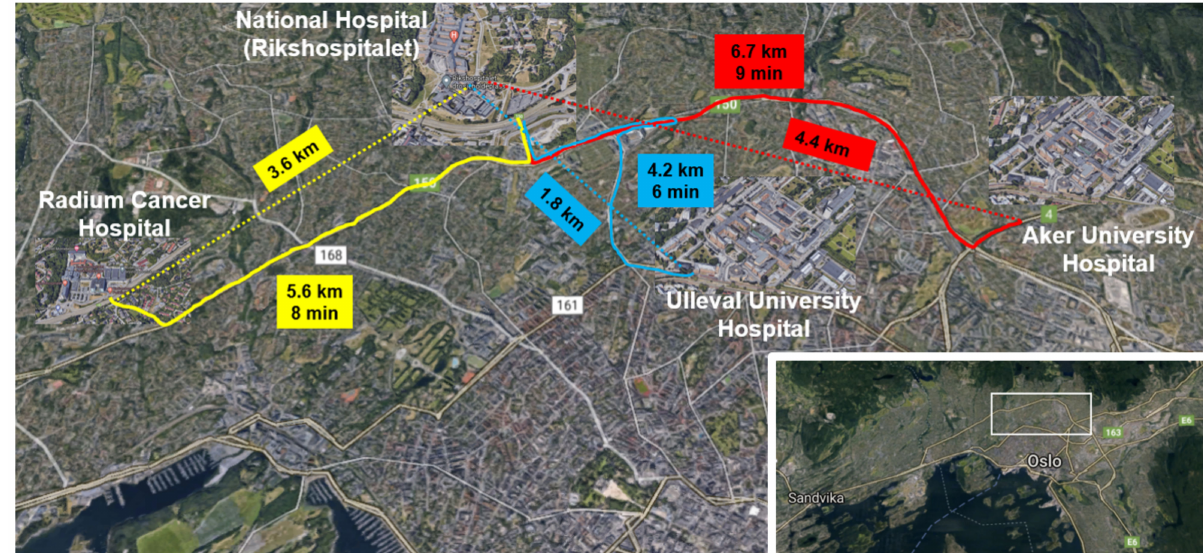
Figure 1. Hospital locations and distances. Lower-right corner: location in Oslo of the detailed section. Ground routes are labeled with distance and driving time, Straight lines show the Euclidean distances. Red lines: Aker Hospital-National Hospital. Blue lines: Ulleval Hospital-National Hospital. Yellow lines: Radiumhospitalet-National